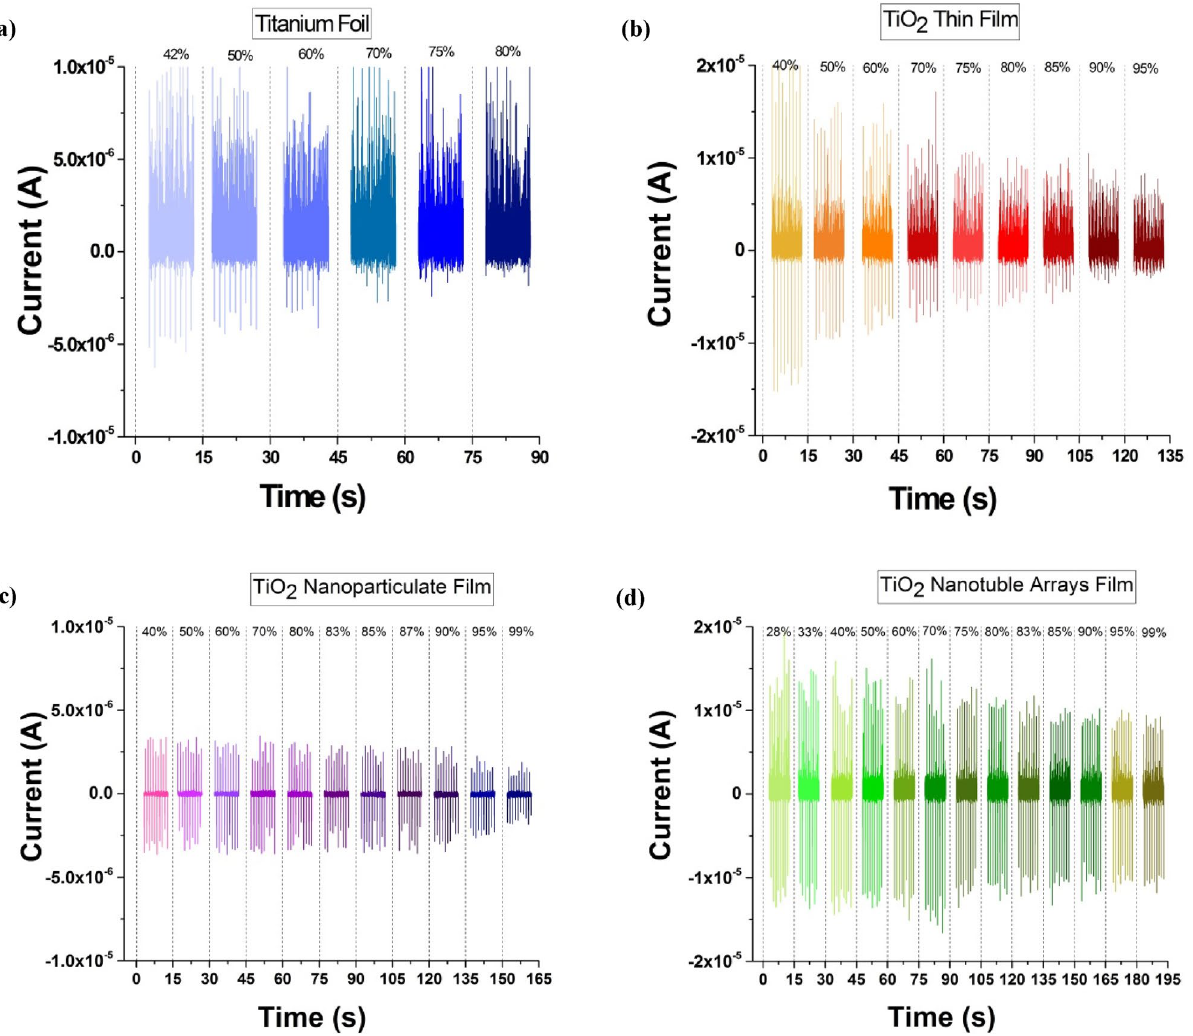
Figure 2. A comparison of the measured current outputs of TENG under various RH between different morphologies of the triboelectric active layer: ( a ) Ti foil, ( b ) TiO 2 thin film, ( c ) TiO 2 nanoparticulate film, and ( d ) TiO 2 nanotube film.